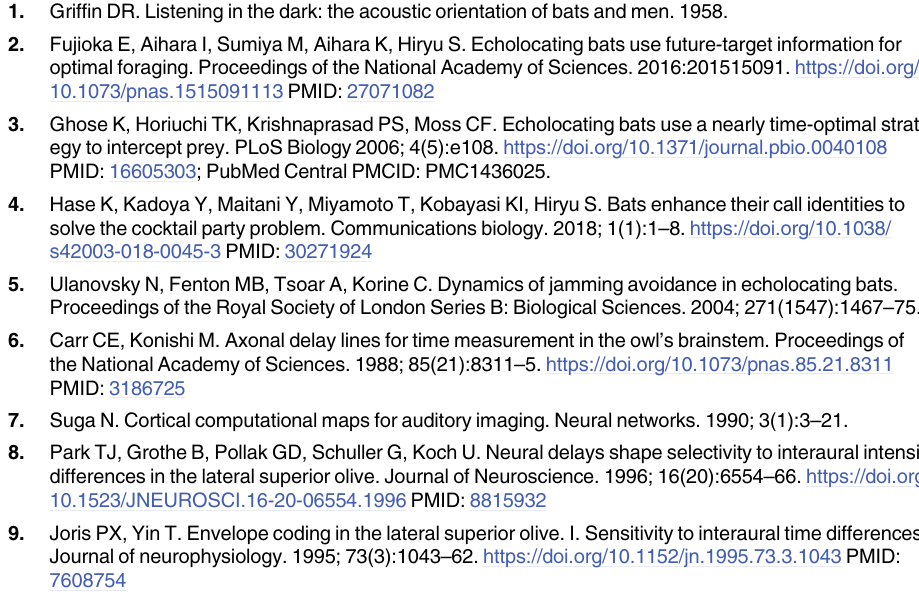
: 0 , φ l ; r : 0 , y l ; r : CONST ]. e e e , guess